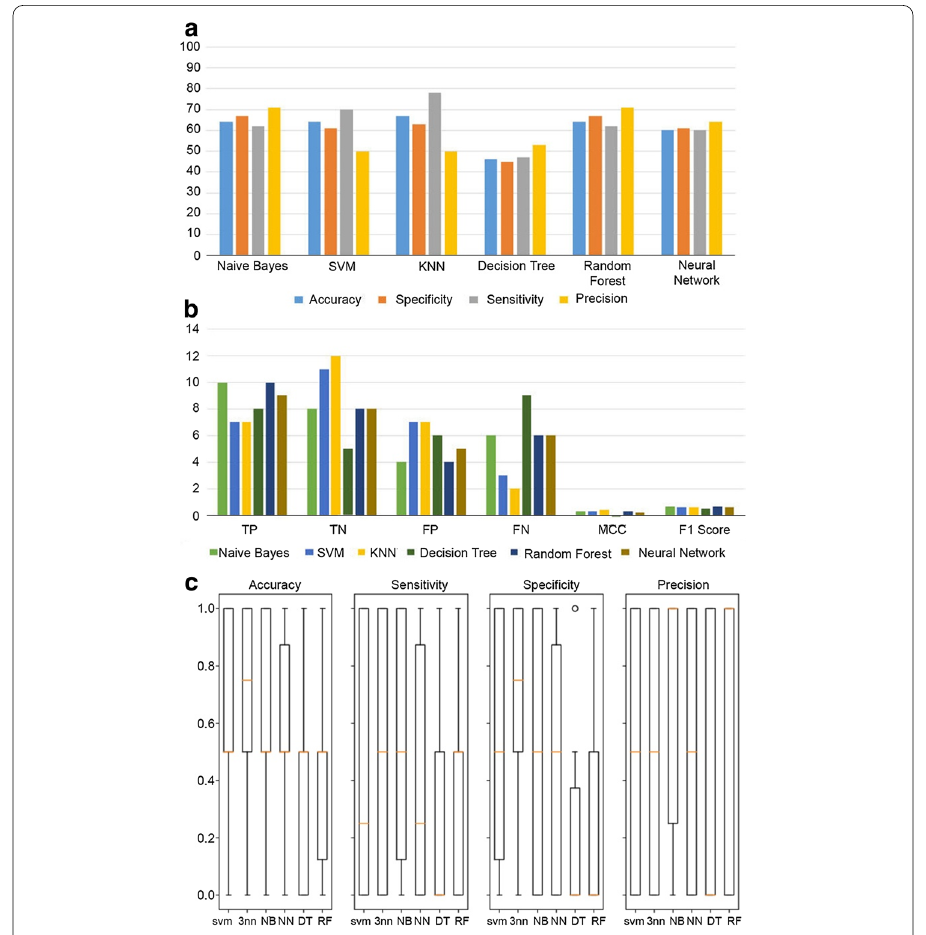
Fig. 3 Performances of the machines trained using the features obtained from the Fisher Score algorithm. a The diagrams show the averages of accuracy, specificity, sensitivity and precision criteria. b The diagrams illustrate the averages of TP, TN, FP, FN, MCC and F1 Scores. c The box plots show performances of the six proposed machines based on the accuracy, sensitivity, specificity and precision